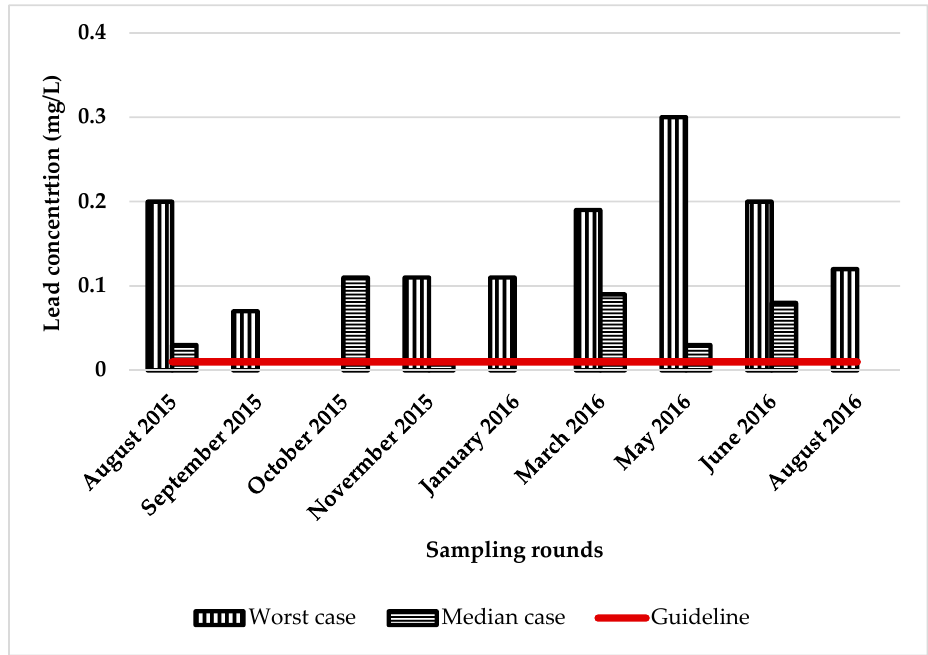
Figure 3. Levels of lead in the worst and median tanks.